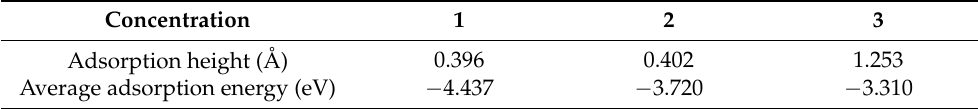
Table 4. Adsorption height and adsorption energy of Li ( x ) -VGDY.